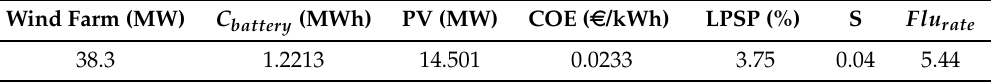
Table 1. Optimal HWSPS configurations from the proposed approach.